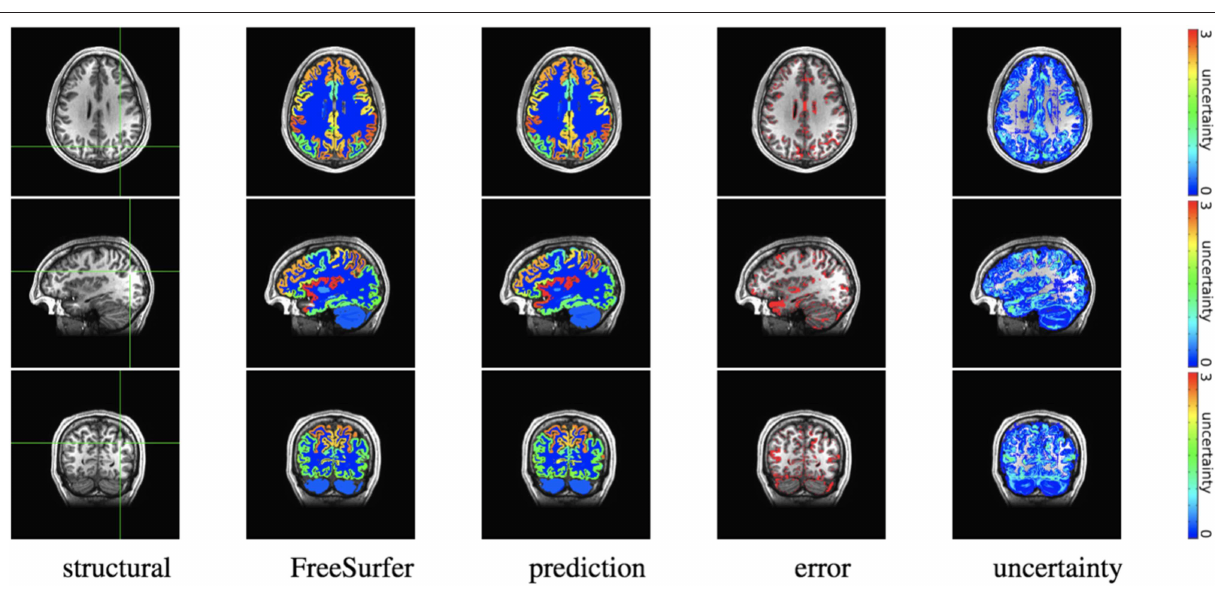
FIGURE 5 | Out-of-site segmentation results for the spike-and-slab dropout (SSD) network for a test subject with average Dice performance. The columns show, respectively, the structural image used as input, the FreeSurfer segmentation used as a prediction target, the prediction made by our network, the voxels where there was a mismatch between prediction and target, and the prediction uncertainty at each